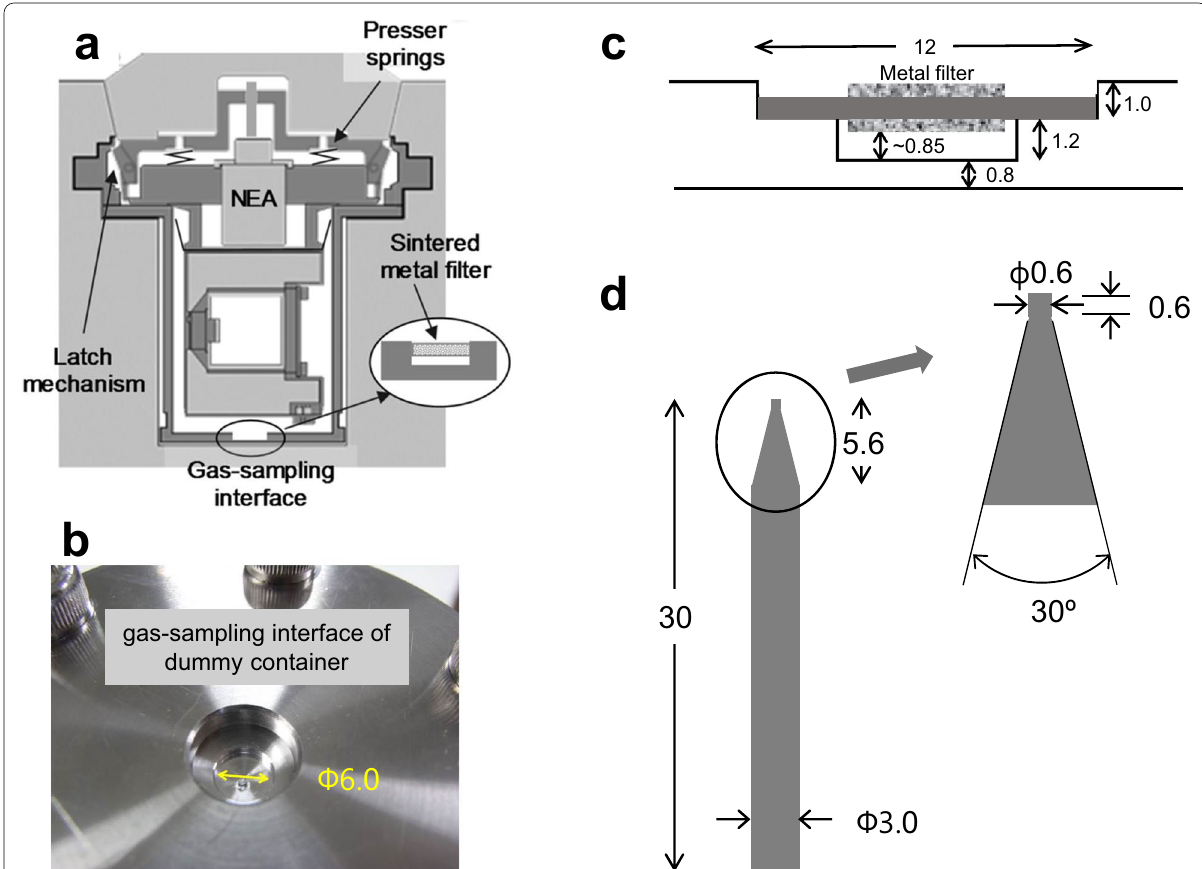
Fig. 2 Gas sampling interface and needle for the Hayabusa2 gas collection with the Keyhole System (HAWKS). a Cross section of the Hayabusa2 sample container (after Okazaki et al. 2017); b photograph for the gas-sampling interface of a dummy container; c dimension for the gas-sampling interface at the bottom of the sample container, where the metal filter adopted here is Swagelok SS-4-VCR-2-.5 M (made of SS (stainless steel) 316 and the defined pore size is 0.5–2 μm), and d schematic drawing of the needle that we used for the actual operation at Woomera. The numbers are the sizes given in